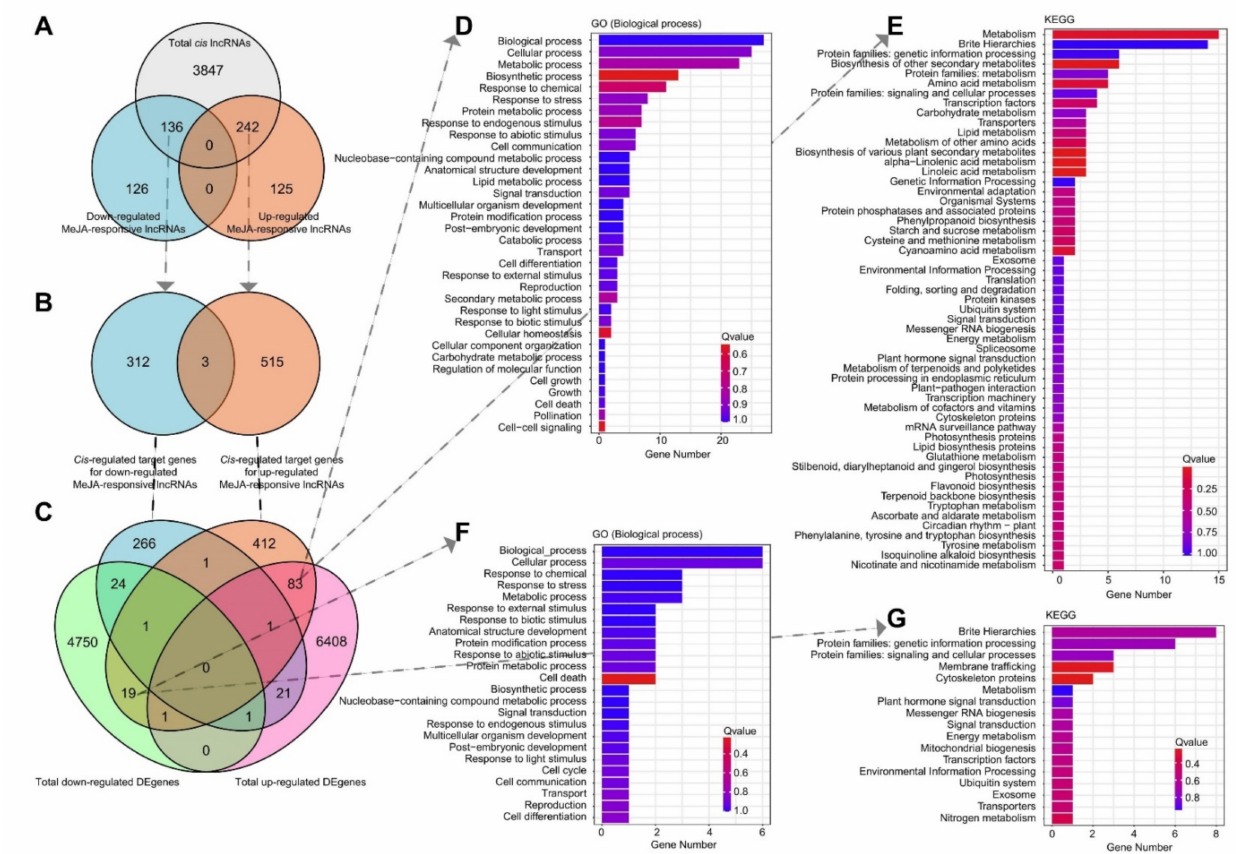
Figure 4. Prediction and functional enrichment of potential cis -regulated target genes of MeJA- responsive lncRNAs. ( A ) Numbers of up- and downregulated cis -regulated MeJA-responsive lncR- NAs. ( B ) Numbers of cis -regulated target genes of up- and downregulated MeJA-responsive lncRNAs. ( C ) Expression pattern comparison of cis -regulated target genes and MeJA-responsive lncRNAs. ( D , E ) Potential biological function enrichment of 83 upregulated cis -regulated target genes of upregulated MeJA-responsive lncRNAs. ( F , G ) Potential biological function enrichment of 19 downregulated cis -regulated target genes of upregulated MeJA-responsive